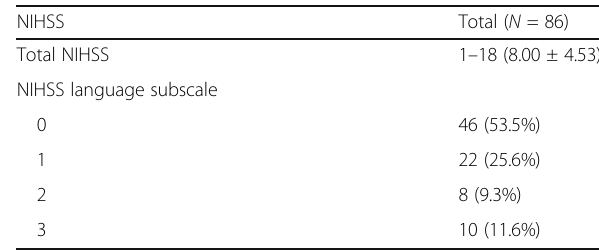
Table 2 Demographic data distribution of the study group Demographic data